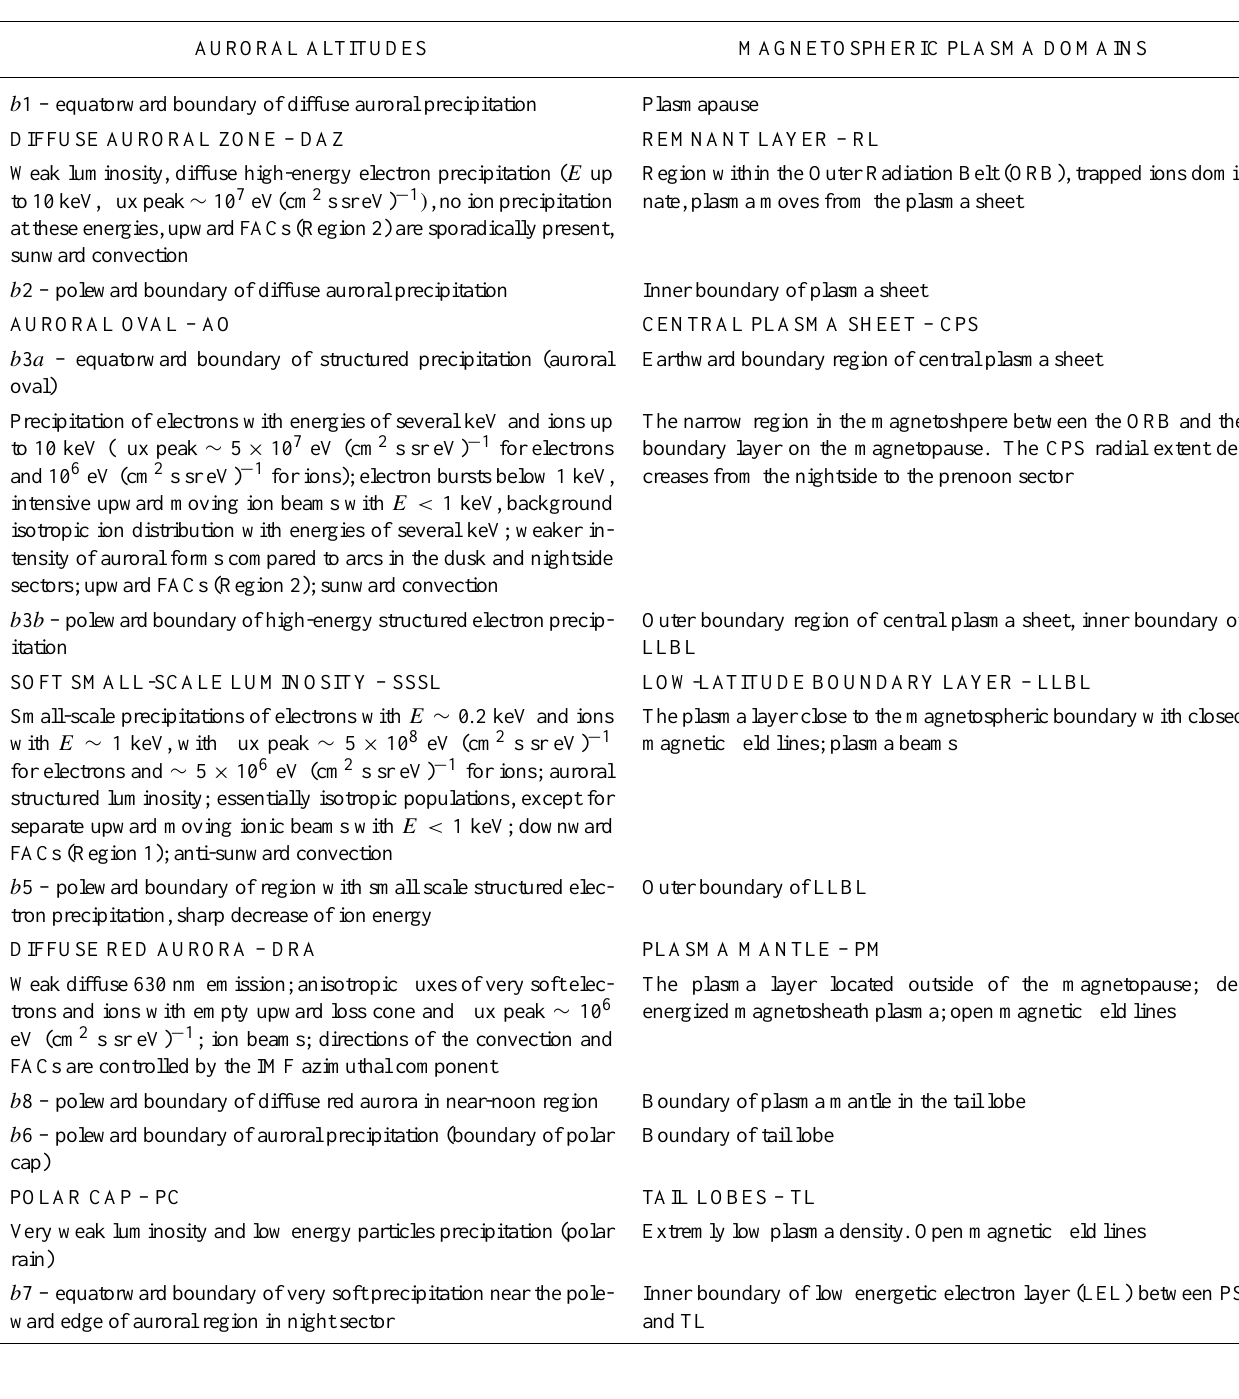
Table 1. Characterization, boundaries and mapping at the dawn sector precipitation regions to magnetospheric plasma